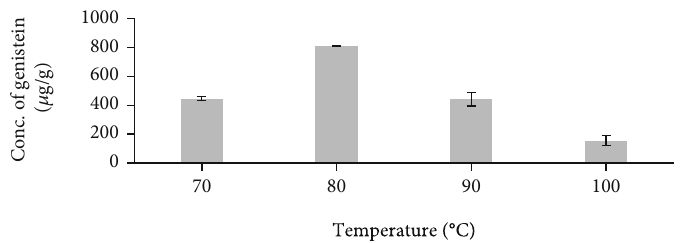
Figure 6: In fl uence of di ff erent temperature degree on Cuminum cyminum genistein content. (100mL of solvent (50 mL Methanol+25mL Dimethyl sulphoxide+25 mL Water ( v / v / v )) and time, 1 h). (The bars show the mean values from three replicates ( n = 3 ) with the respective standard